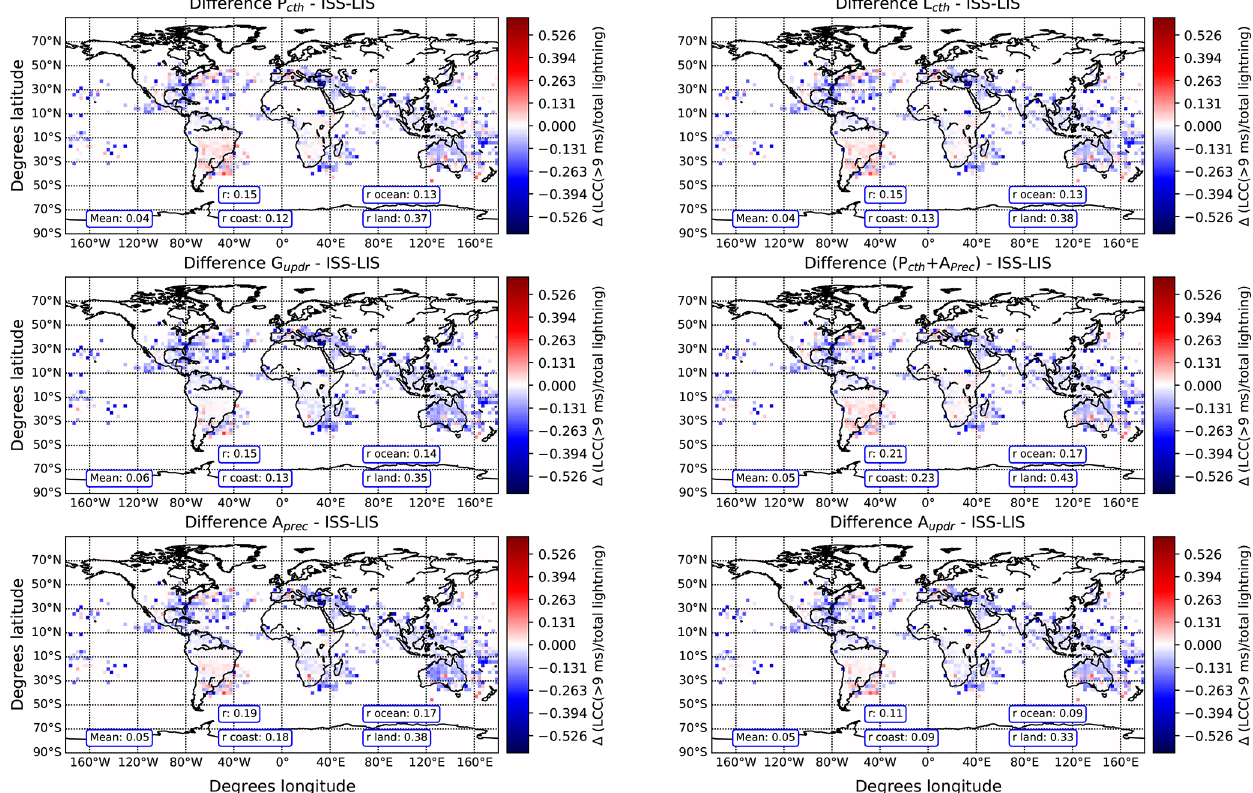
Figure 12. Difference between the observed and simulated ratio of LCC( > 9ms) lightning to total lightning density in September, October, and November using different lightning parameterizations. Positive values indicate that the model overestimates the ratio. The calculated global, land, and ocean spatial correlation coefficients r are